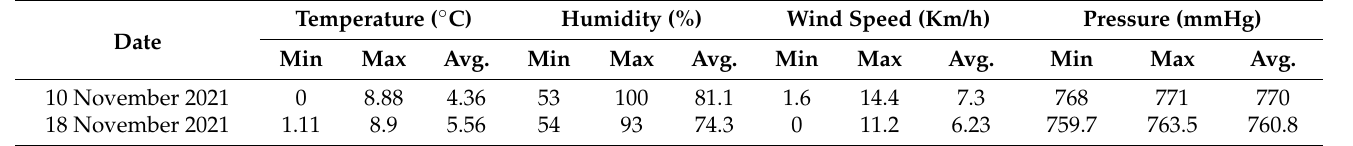
Table 2. Data regarding weather conditions for the 10 and 18 November